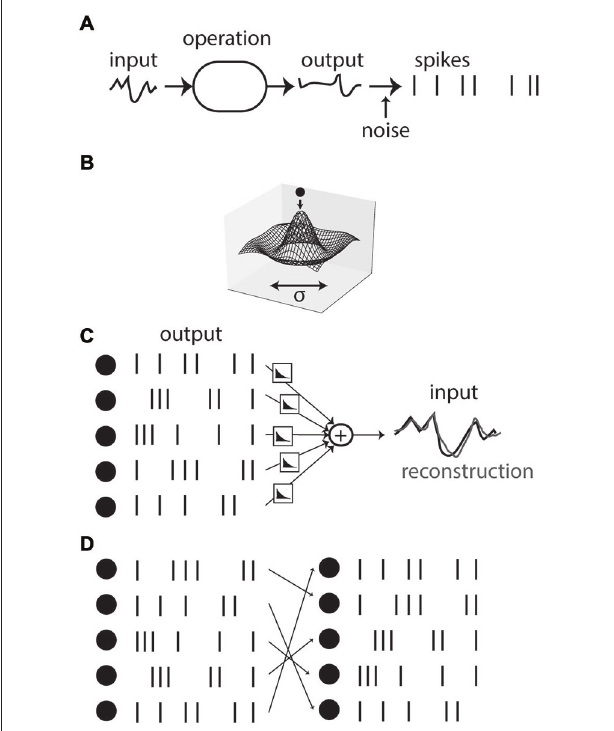
FIGURE 3 | Variability due to degeneracy . (A) Spikes can be seen as the result of a sequence of operations applied on an input signal, followed by spike generation. In this view, variability comes from noise added in the spiking process. (B) The state of a physical system can often be described as a minimum of energy. Symmetries in the energy landscape can imply observed variability, whose magnitude bears no relation with the amount of intrinsic noise. (C) An example of the energy view is spike-based sparse coding. A reconstruction of the signal is obtained from combining filtered spike trains together, and spikes are timed so as to make the reconstruction accurate. (D) If the system is redundant, the reconstruction problem is degenerate, leading to several equally accurate spiking solutions (here obtained by permutation of